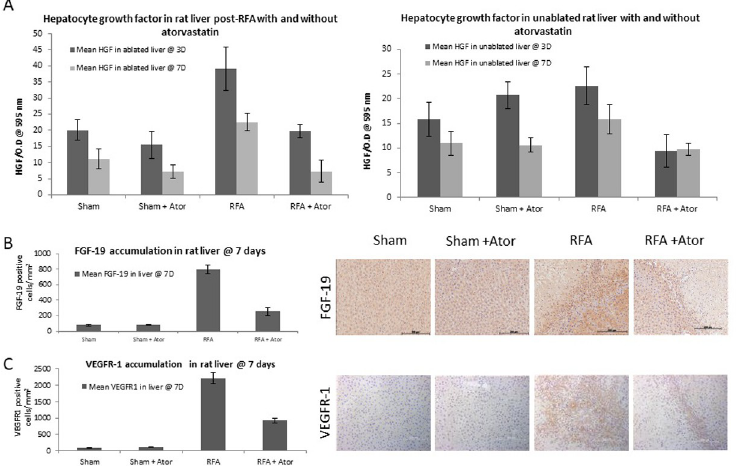
Fig 2. Myofibroblast blockade inhibits RFA-induced upregulation of tumor promoting cytokines. Ablated (and un-ablated, HGF only) livers were analyzed for known RF induced tumorigenic growth factors (HGF and VEGFR-1) as well as myofibroblast dependent growth tumorigenic growth factors (FGF-19). (A) Enzyme-Linked immunosorbent assays (ELISA) demonstrated statistically significant elevated levels of HGF in the RFA group when compared to control groups and RFA plus atorvastatin (p-value < 0.05 for all comparisons) in treated rat liver. No statistically significant difference was detected between RFA plus atorvastatin and control groups at 3 and 7 days (p-value > 0.1, all comparisons). ELISA also demonstrated statistically significantly elevated HGF levels in non-ablated rat liver with RFA treatment in comparison to control groups and combined atorvastatin with RFA at 3 and 7 days post-ablation (p- value < 0.05, all comparisons), with, no statistically significant difference detected between RFA plus atorvastatin treatment and control groups (p-value > 0.1, all comparisons). Significantly increased FGF-19 (B) and VEGRFR-1 (C) levels were demonstrated in RFA compared to sham or sham plus atorvastatin 7 day post-treatment (p-value < 0.001, all comparisons) and were successfully reduced to half in RFA plus atorvastatin (p-value < 0.001, all comparisons with RFA and p-value < 0.001, for all comparisons to control